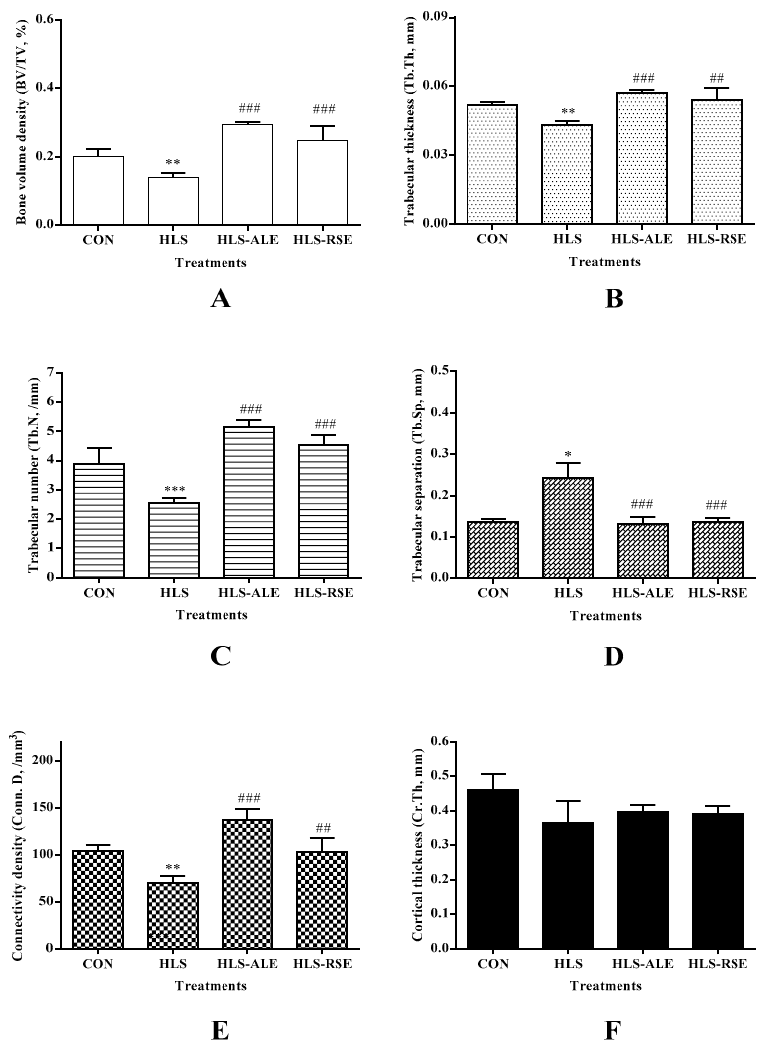
Figure 4. Measurements of femoral trabecula within various treatment groups: ( A ) bone volume density (BV/TV); ( B ) trabecular thickness (Tb.Th); ( C ) trabecular number (Tb.N); ( D ) trabecular separation (Tb.Sp), ( E ) connectivity density (Conn. D) as well as ( F ) cortical thickness (Cr. Th) ( n = 6). CON: control group; HLS: hindlimb suspended group; HLS-ALE: group administrated with alendronate (2 mg/kg/day); HLS-RSE: group administrated with Radix Scutellariae extract (50 mg/kg/day); * versus CON group: * p < 0.05, ** p < 0.01, *** p < 0.001; # versus HLS group: ## p < 0.01, ### p < 0.001.